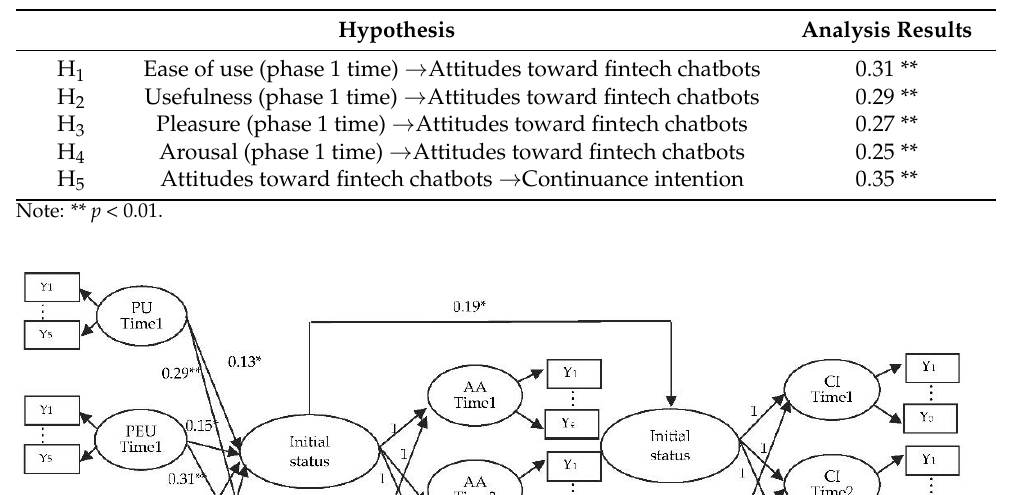
Table 3. Analysis results.